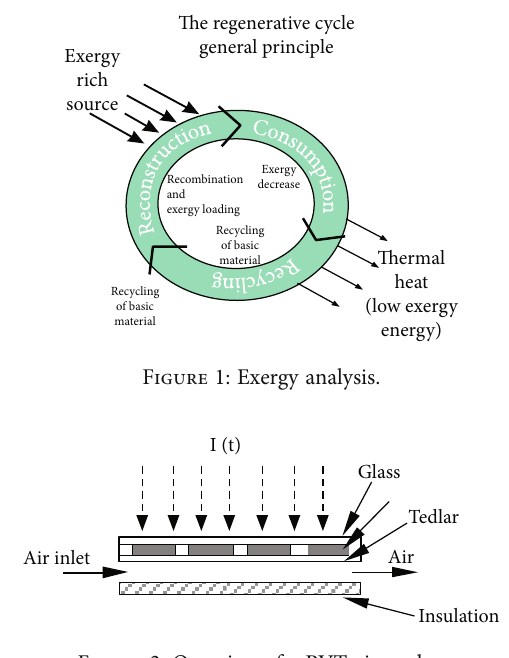
Figure 2: Overview of a PVT air cooler. Table 1: Photovoltaic module speci fi cations.